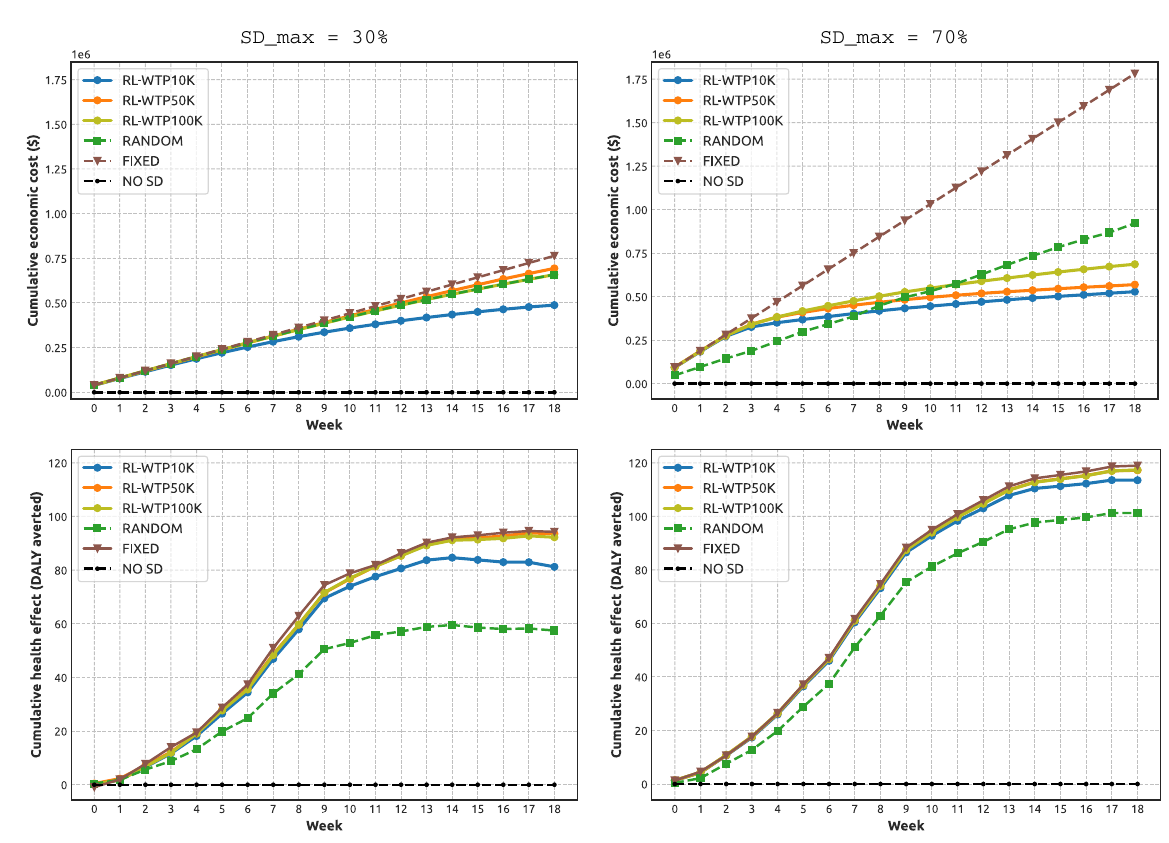
Figure 4. Components of the Net Health Benefit (NHB): mean values of cumulative economic costs (dollars) and cumulative health effect (DALY averted), shown for different NPIs: adaptive SD with three WTP thresholds ($10K per DALY, $50K per DALY and $100K per DALY), random SD, fixed SD, and zero SD. Left: the maximal SD level SD max is set at 30%. Right: the maximal SD level SD max is set at